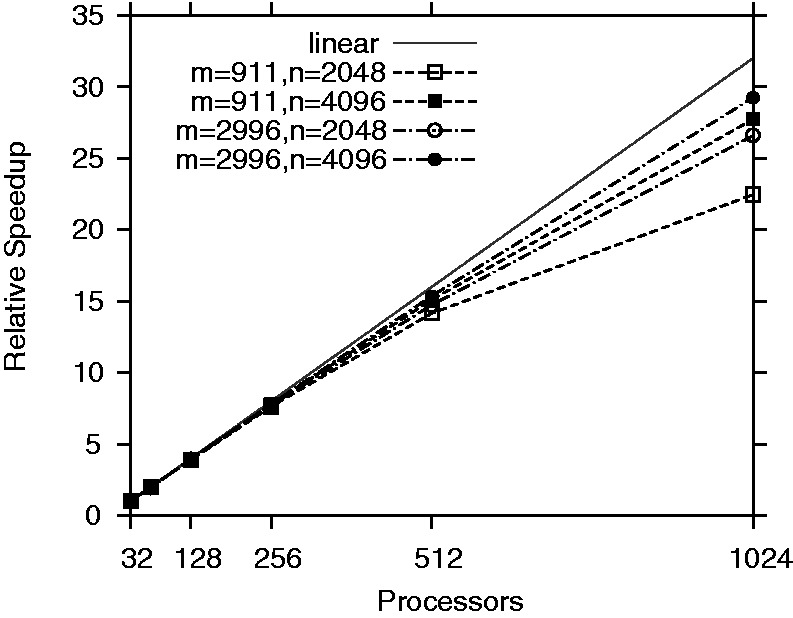
Scalability of TINGe for datasets with different numbers of genes n, and different numbers of expression observations m.